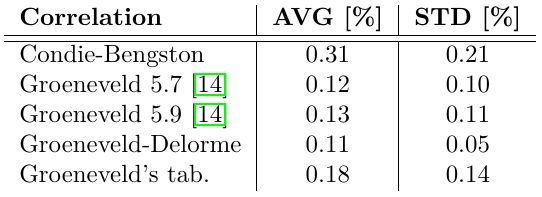
Table 3. The statistical summary of comparison of TUBE 2.0 and SUBCAL with the use of 12202 points from Becker’s experimental database.